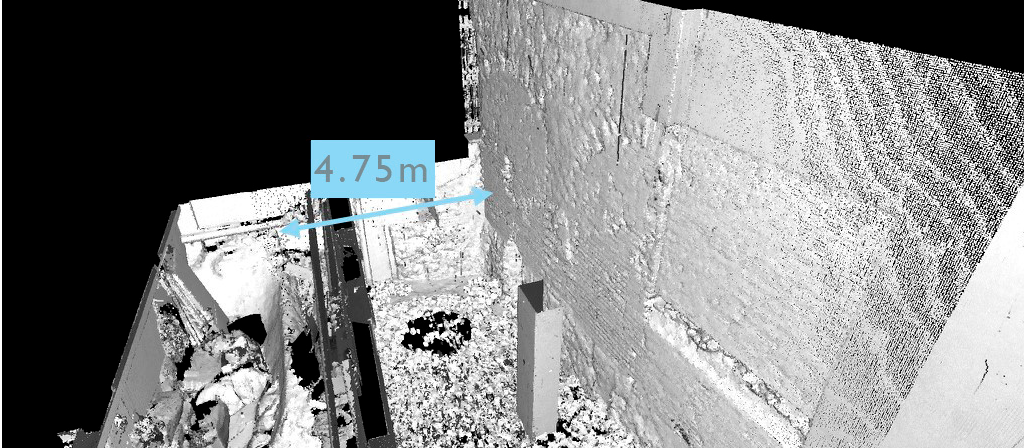
Figure 5. Documentation of the main portion of the circus outer wall still standing: laser scan including a small remnant of the inner wall found in a private basement, providing the height of the wall in this point of the structure, and its distance from the inner